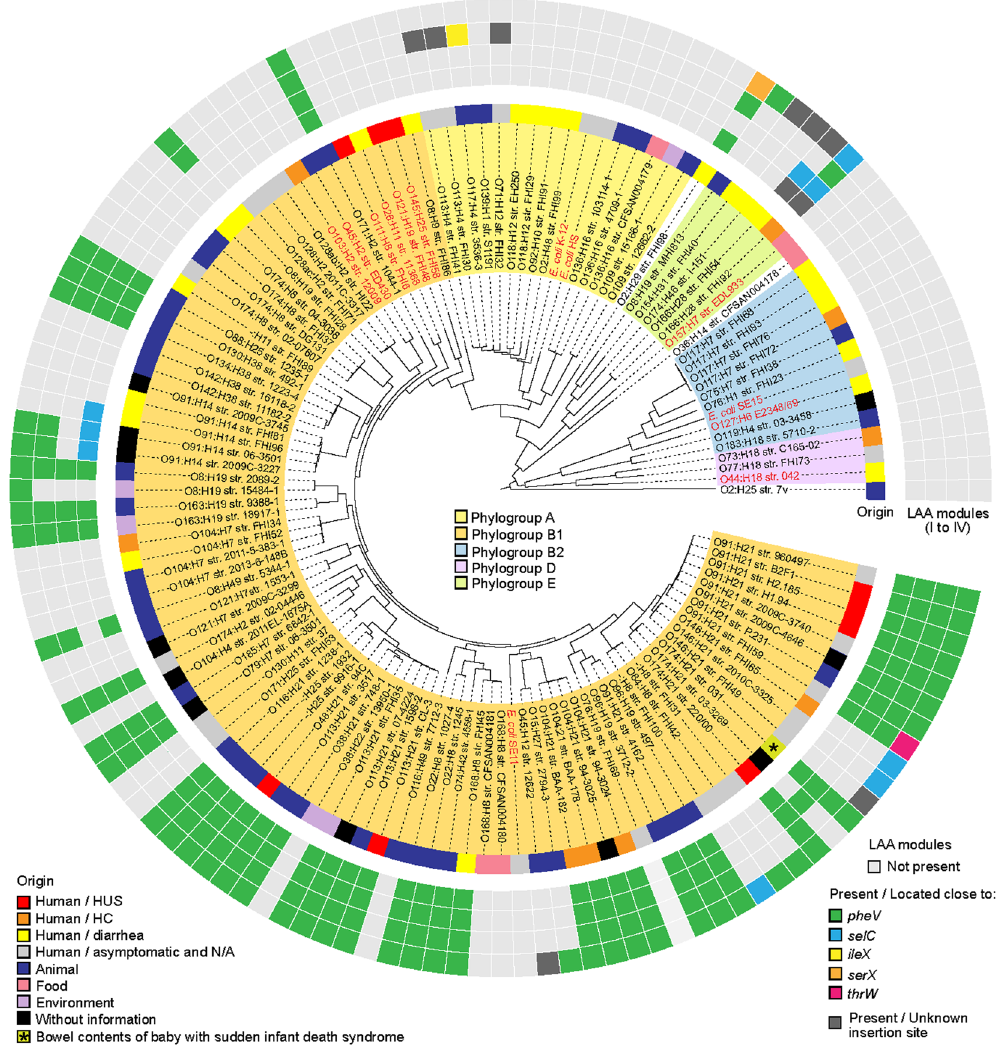
Figure 5. Phylogenetic relationship and distribution of LAA modules between LEE-negative STEC strains and related E. coli strains. A total of 128 E. coli genomes (115 LEE-negative STEC and 13 representative strains of other E. coli strains) were used to construct the maximum likelihood phylogenetic tree (midpoint rooted) based on whole genome SNPs (167,167 SNPs within 3,008,649 positions, which were found in all analyzed genomes). Phylogroups are indicated by the colors of the inner ring, according to the legend. The origin of each isolate is indicated in the middle ring by colored boxes, according to the legend. Presence of the LAA pathogenicity island or LAA modules and their insertion sites are indicated in the outermost rings by colored boxes, according to the legend. LEE-negative STEC strains and related E. coli strains are highlighted in black and red,